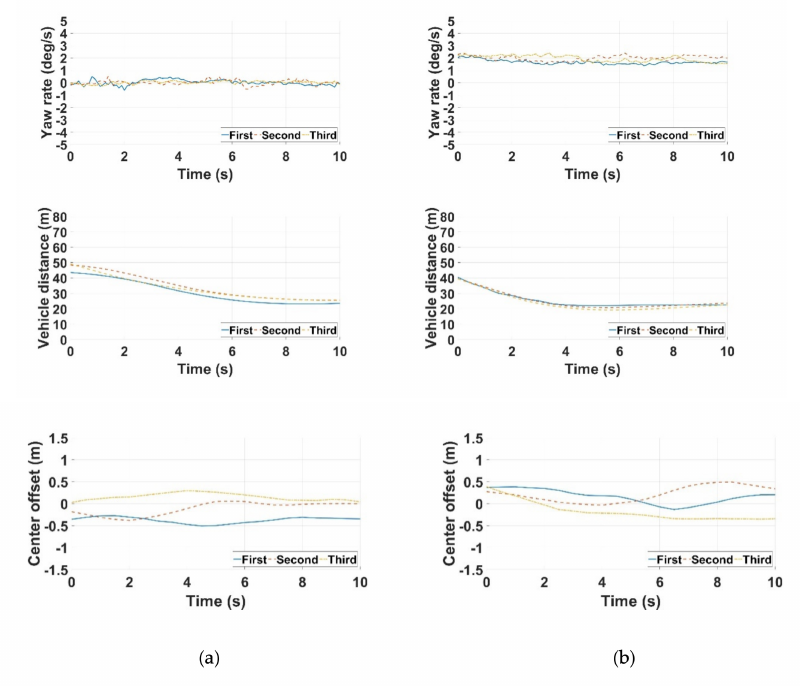
Figure 10. Yaw rate, distance to the lead vehicle, and distance to the center of the lane: ( a ) scenario 9 and ( b ) scenario 10.